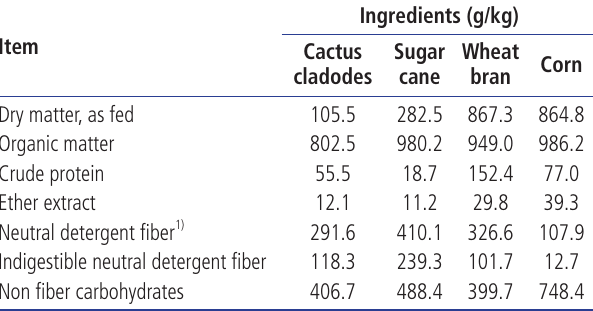
Table 1. Chemical composition of ingredients (g/kg of dry matter)